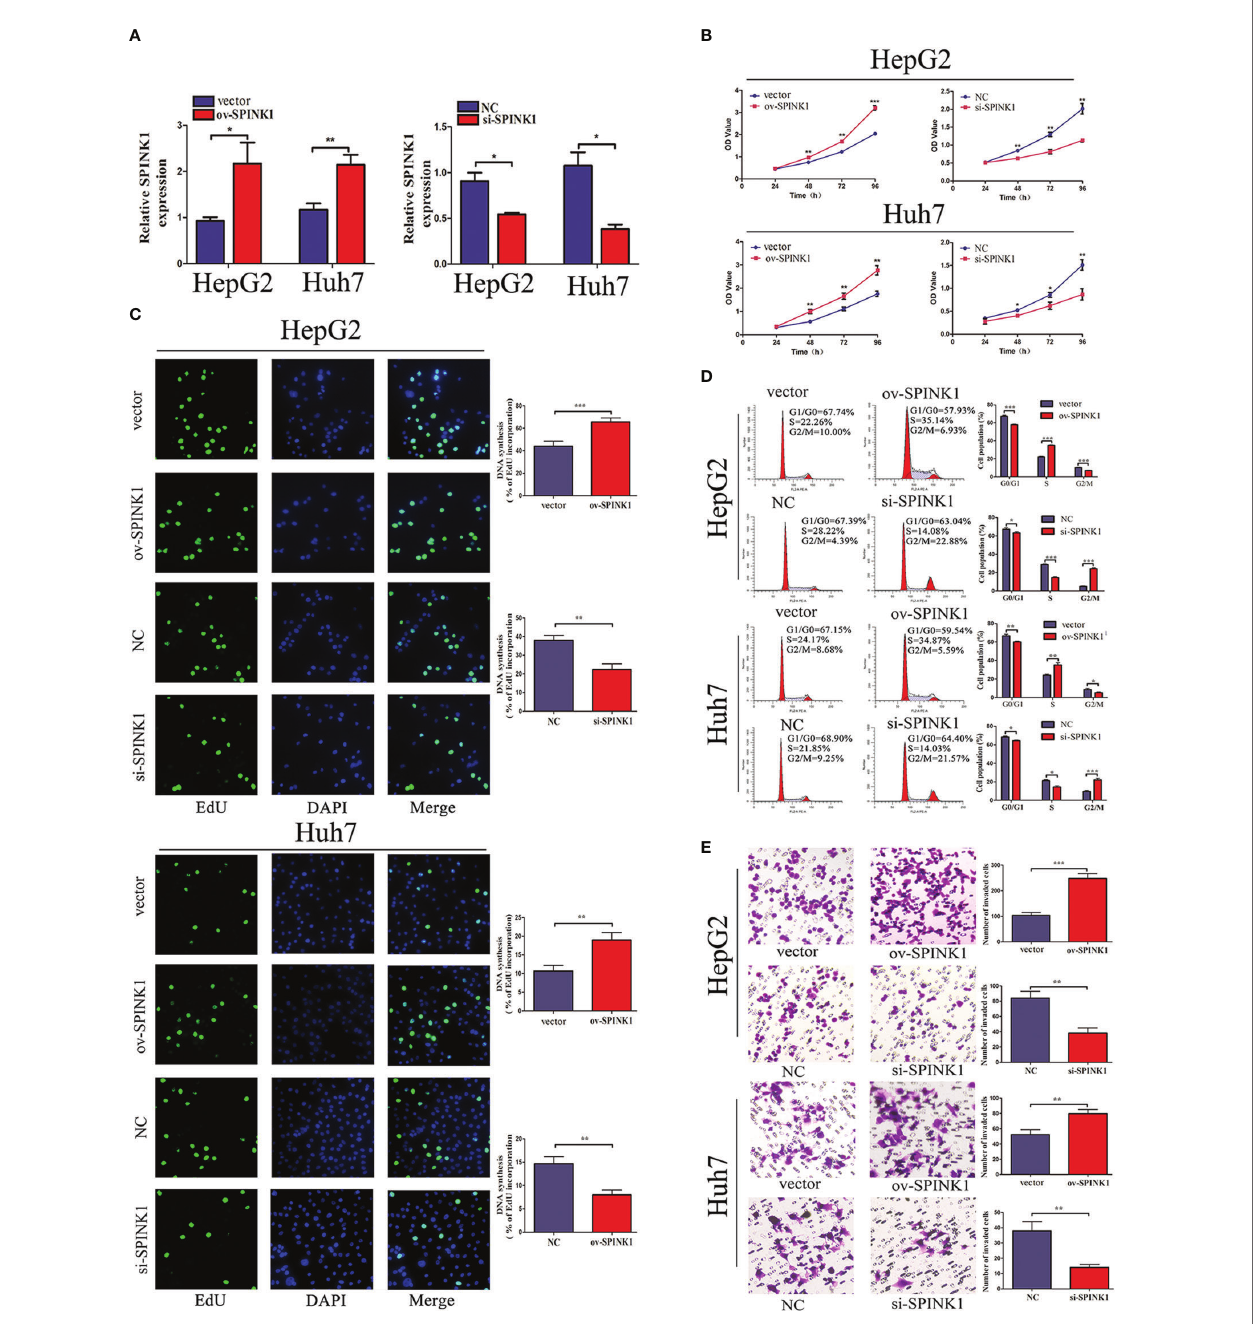
FIGURE 2 | SPINK1 regulates HCC cell proliferation, cell cycle, and invasion capacity. (A) The qRT-PCR results reveal the SPINK1 expression level after transfection of SPINK1 overexpression vector or siRNA. Independent experiments were repeated three times; data are presented as mean ± SD; statistical signi fi cance was assessed by paired t -test. * p < 0.05, ** p < 0.01. (B) CCK-8 and (C) EdU assays reveal SPINK1 overexpression (ov) promotes and knockdown (si) inhibits the proliferation of HCC cells. Independent experiments were repeated three times; data are presented as mean ± SD; statistical signi fi cance was assessed by Student ’ s t -test. * p < 0.05, ** p < 0.01. (D) Flow cytometry shows SPINK1 overexpression accelerates cell cycle, while, SPINK1 knockdown induces cell cycle arrest. Independent experiments were repeated three times; data are presented as mean ± SD; statistical signi fi cance was assessed by Student ’ s t -test. * p < 0.05, ** p < 0.01, *** p < 0.001. (E) Transwell assays revealed SPINK1 overexpression promoted and its knockdown attenuated the invasion of HCC cells. Independent experiments were repeated three times; data are presented as mean ± SD; statistical signi fi cance was assessed by Student ’ s t -test. ** p < 0.01, *** p < 0.001. ov, overexpressed plasmid vector; si, siRNA; NC, negative